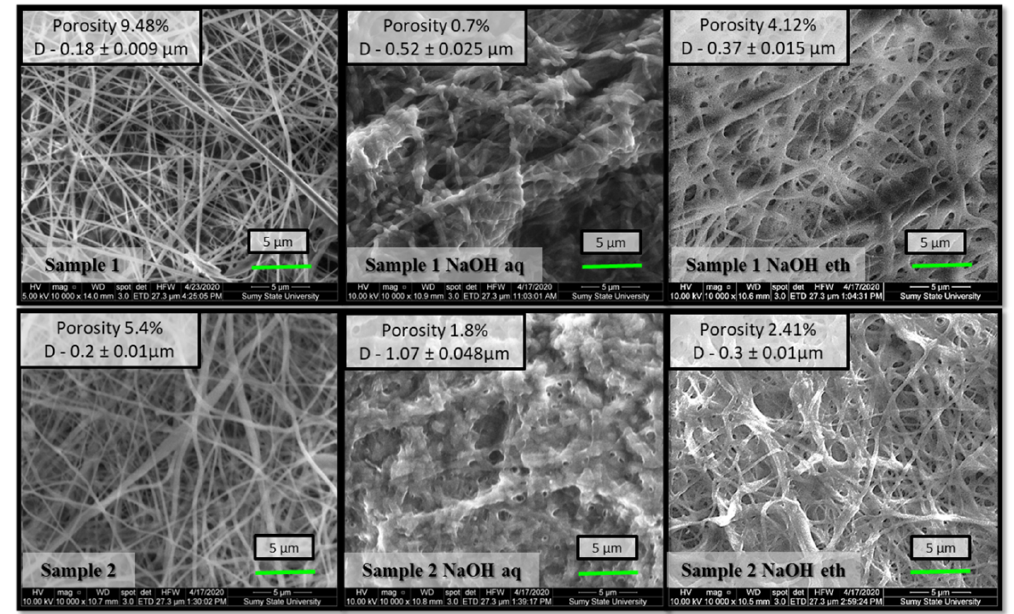
Figure 3. Scanning electron micrographs with ‘porous area fraction’ of sample 1 (Ch-TFA:DCM 7:3) and sample 2 (Ch-TFA:DCM 9:1) electrospun membranes after NaOH aqueous and NaOH ethanol treatment.